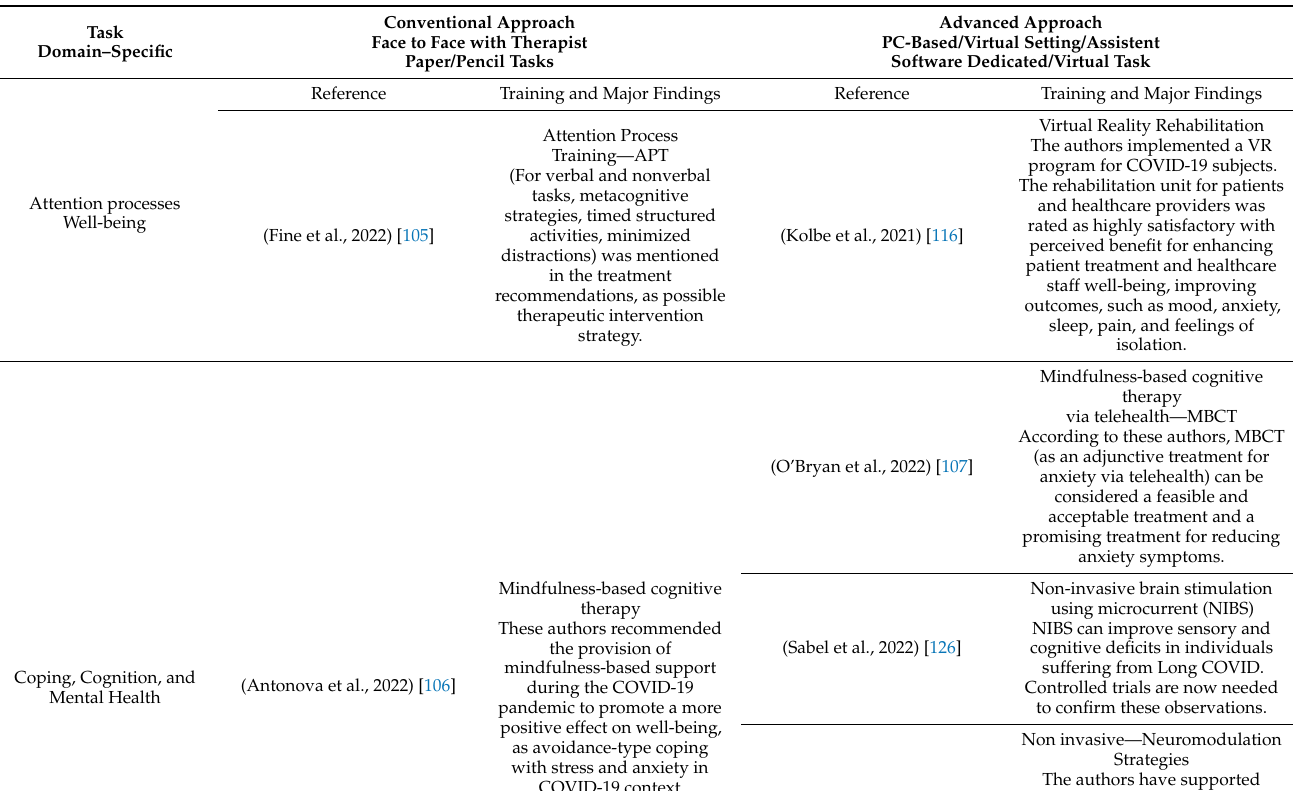
Table 2. The main conventional and advanced techniques used in the Long COVID treatment of psychological and cognitive sequelae, reporting major findings according to current